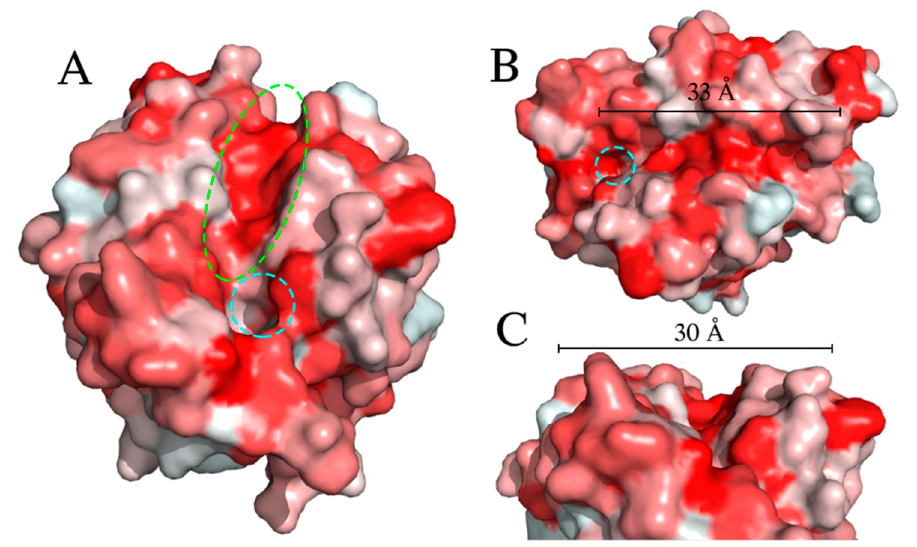
Figure 4. Hydrophobicity surface model of EstB. Red indicates hydrophobic regions; white indicates hydrophilic regions. ( A ) Front view of the potential substrate binding site of EstB. Catalytic residue Ser114 is indicated by dotted cyan circle, binding cleft is indicated dotted green circle. ( B ) Length of binding cleft. Catalytic residue S114 is indicated by dotted cyan circle. ( C ) Width of binding cleft.